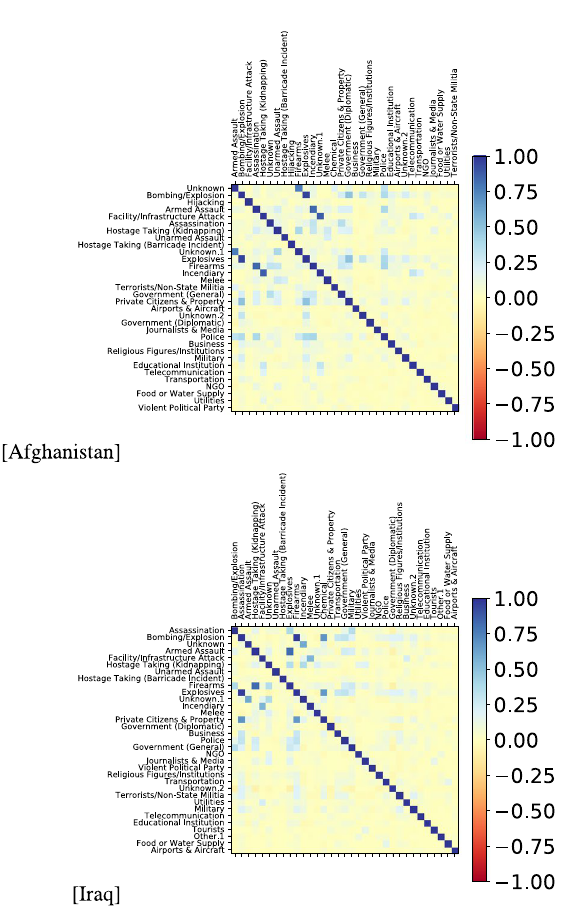
Figure 4. Pearson’s correlation of centrality values among all features F = | X | + | W | + | Y | for the entire time- span U . The figures have been created using Matplotlib version 3.1.3. https:// matpl otlib. org/3. 1.3/ conte nts.